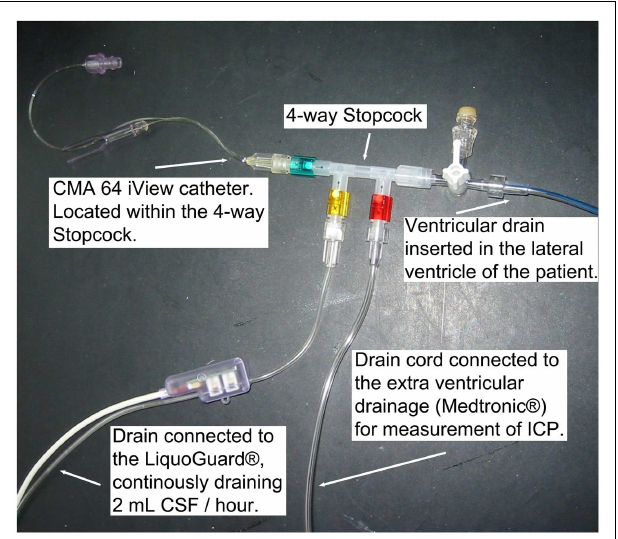
FIGURE 1 |The monitoring setup, illustrating the CMA 64 MD catheter in a closed system of flowing CSF .